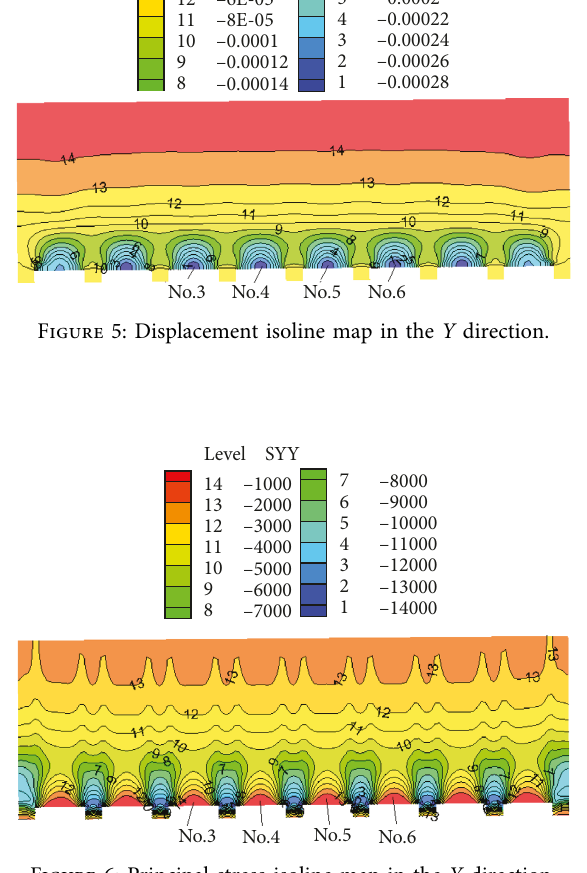
Figure 7: Y -directional principal stress curve at midspan of soil arch.